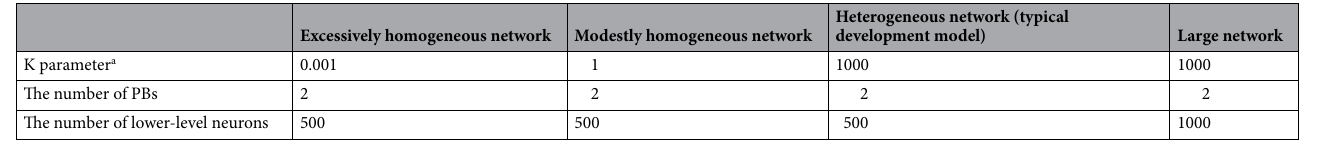
Table 1. The representative neural network models for experiment. PB parametric bias. a K parameter is the variance in activity thresholds in lower-level neurons (Eq. (5) in the Supplementary Methods), which determines the intrinsic heterogeneity of network excitability. When the parameter K is larger, the network excitability becomes more